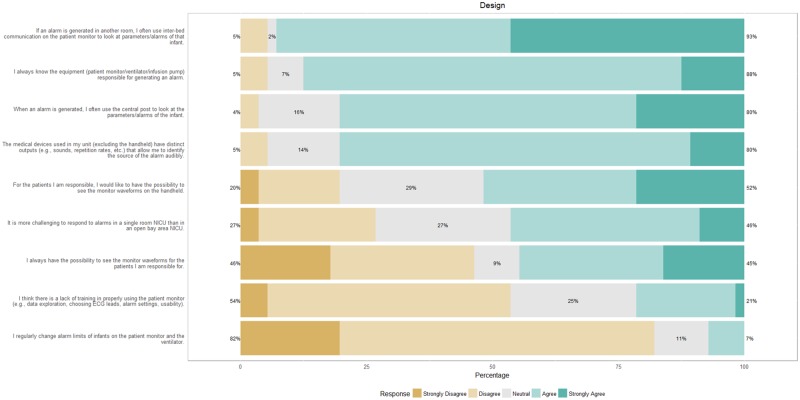
Response of nurses on how design affects alarms.